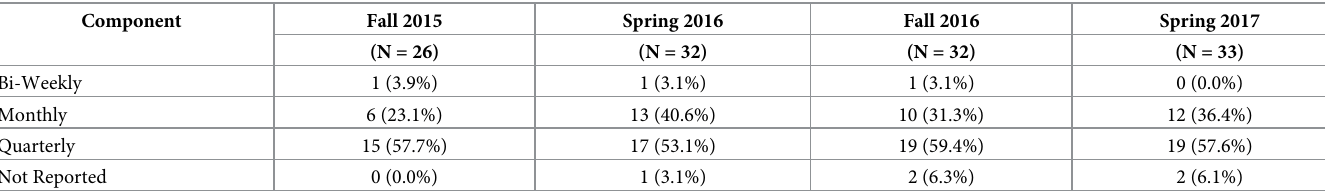
Table 1. Frequency of vascular access committee meetings a